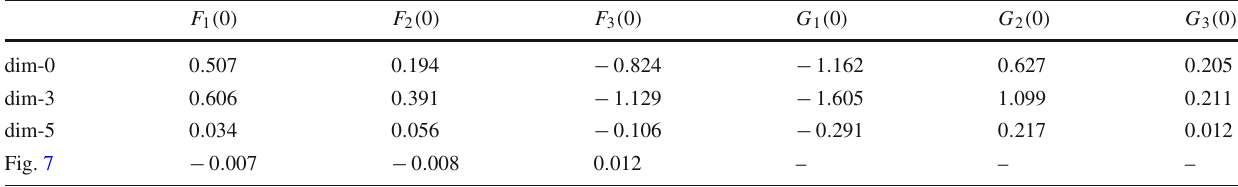
Table 6 Contributions to form factors from dim-0, -3, -5 and the gluon–gluon condensate shown in Fig. 7 for the (cid:2) ++ cc → (cid:6) + c transition with T 2 taking as the central value 5 . 9 GeV 2